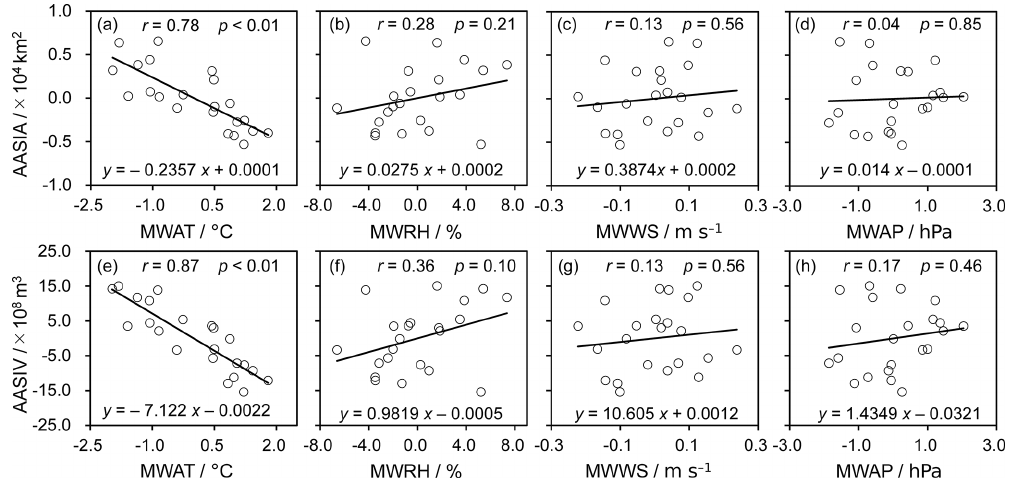
Figure 20. Pearson correlations between annual average sea ice area (AASIA) (a–d) and annual average sea ice volume (AASIV) (e–h) and mean winter air temperature (MWAT), mean winter relative humidity (MWRH), mean winter wind speed (MWWS), and mean winter air pressure (MWAP) through detrended analysis for the period 1996–2017. The climate parameters are calculated based on the measured daily meteorological data at 12 meteorological stations surrounding the Bohai Sea during the winter (DJFM).